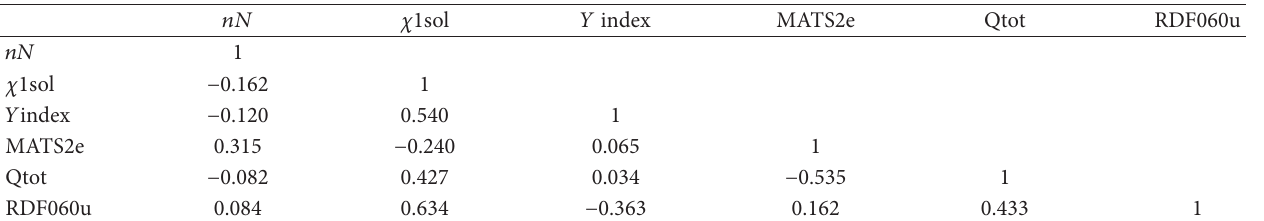
F 4: Plot of the calculated by MLR method versus the experimental values for training, test, and validation sets (a) and the plot of (ANN)) against the experimental values ( retention time values predicted by 6–7–1 feed forward ANN ( 𝑡𝑡 𝑅𝑅 𝑡𝑡 𝑅𝑅 T 3: Correlation matrix for descriptors applying in this